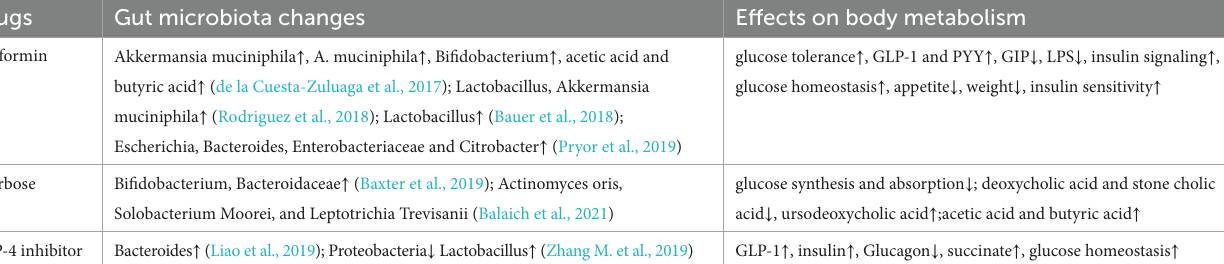
TABLE 2 Effect of hypoglycemic drugs on gut microbiota.